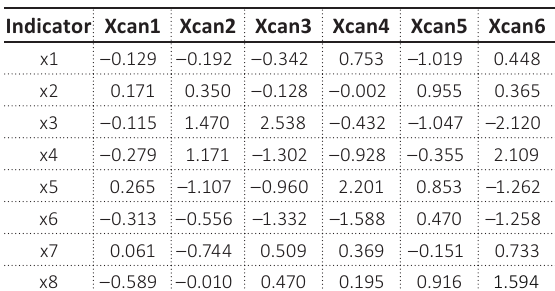
Table 4. Standardized canonical